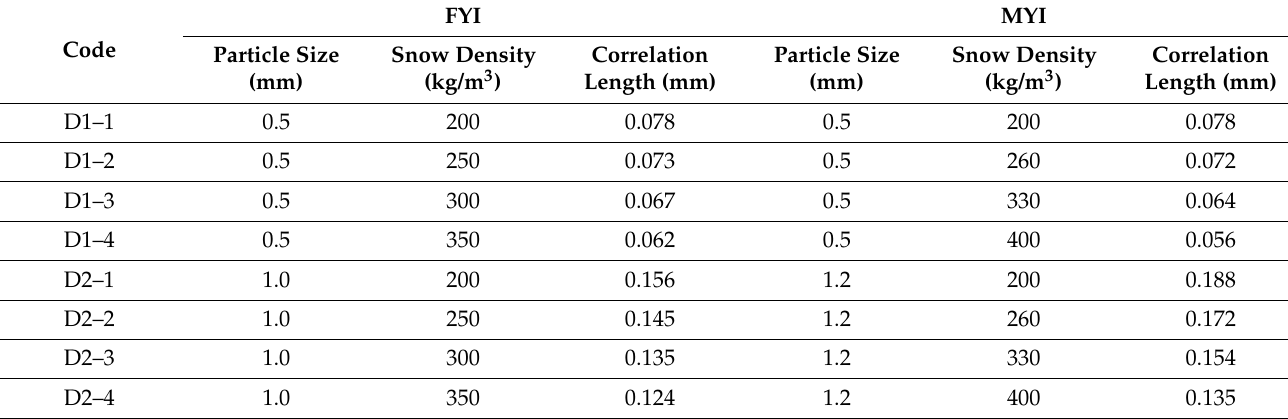
Figure 6. Change in GRs with snow depth on MYI under different conditions. ( a ) GR(10.7 V/18.7 V); ( b ) GR(10.7 V/36.5 V). Table 2. Settings of snow density, particle size, and correlation length in single layer